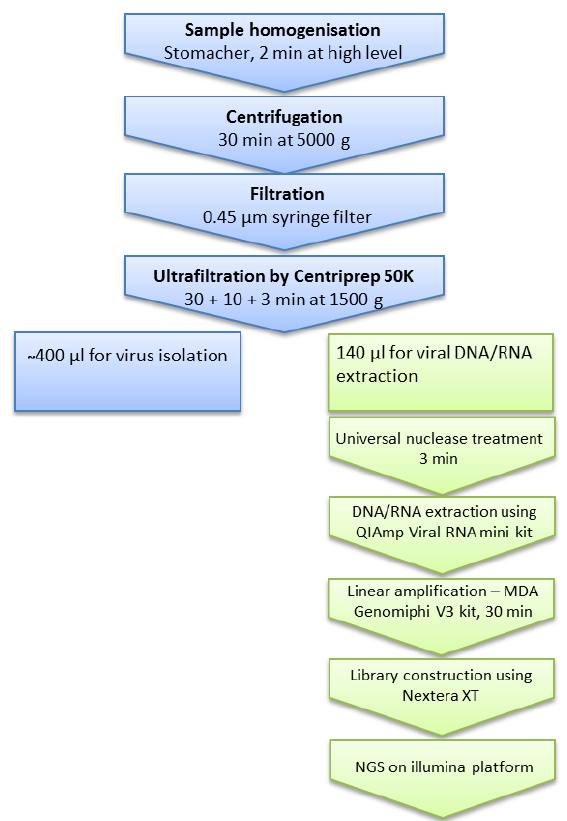
Figure 1. Overview of the virome extraction, amplification, and sequencing procedures. A workflow for gut virome extraction and sequencing was established, the virome isolation part and sequencing part is in blue and green, respectively.